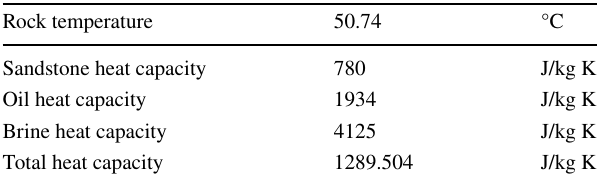
Table 2 Well X − 1 thermal data